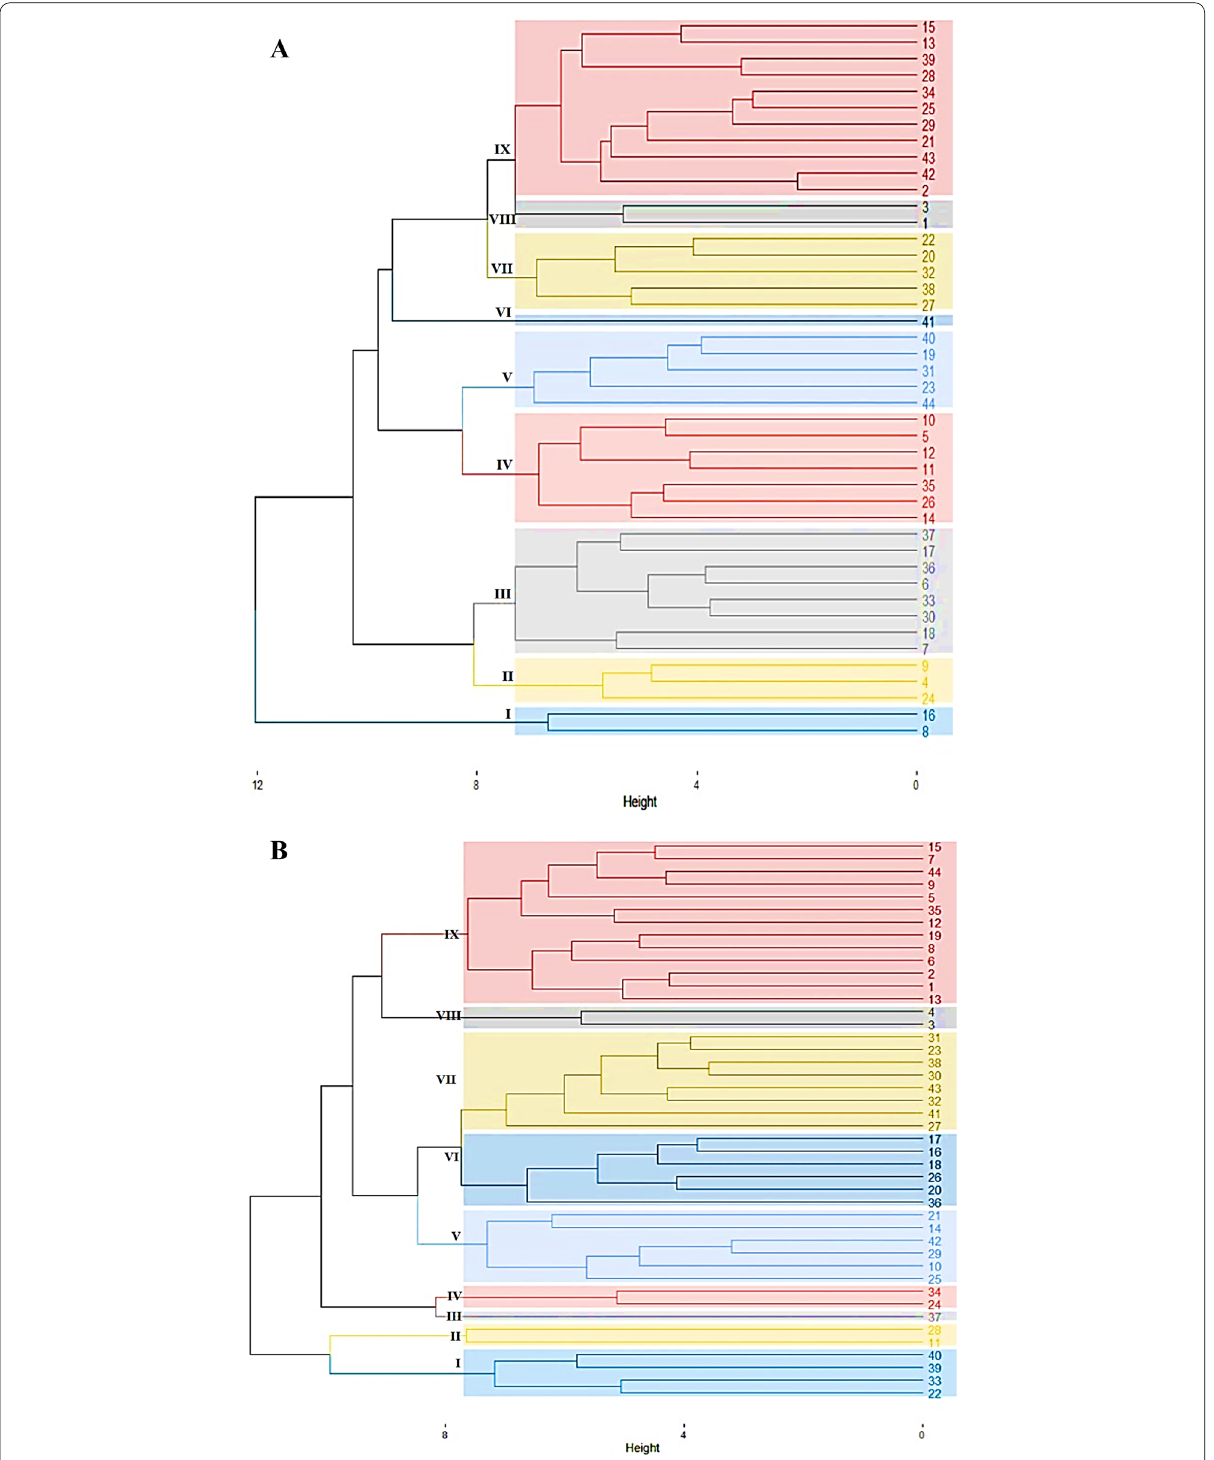
Fig. 6 Cluster analysis of 44 wheat genotypes under normal ( A ) and drought ( B ) field